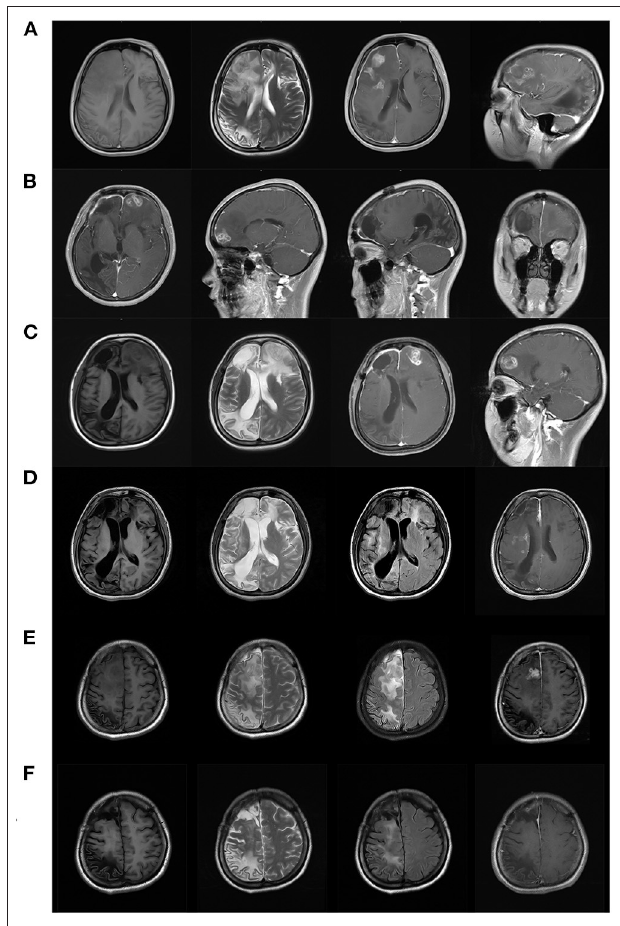
FIGURE 1 | Neuroimaging results of cerebral sparganosis in the case. (A) Six years after the onset (aged 22), tumor-like occupation foci at the right frontal lobe with edema and irregular enhancement causing midline shift on MRI before the first operation. Note that regular ring-shaped enhancement appeared on the sagittal view (the rightmost figure) (Left to right: T1, T2, axial T1 post gad, sagittal T1 post gad). (B) Three months after the operation, the enhanced foci shifted to the left frontal lobe, and postoperative encephalomalacia occurred at the original right frontal lobe on her follow-up MRI images (Left to right: axial T1 post gad, sagittal T1 post gad (left side), sagittal T1 post gad (right side), coronal T1 post gad). (C) Five months after the operation, a typical tunnel sign at the left frontal lobe was found on both axial and sagital view of her repeated MRI with enhancement (Left to right: T1, T2, axial T1 post gad, sagittal T1 post gad). (D) Three years after the operation (aged 25), the patient came to our center with left side paralysis. Restricted enhancement foci in the right centrum semiovale and basal ganglia with punched-out and tunnel-like presentation were found at the right basal ganglia (Left to right: axial T1, T2, T2 FLAIR, T1 post gad). (E) Four years after the operation (aged 26), the larva moved to the superficial area of the right frontal lobe where surgical removal became possible (Left to right: axial T1, T2, T2 FLAIR, T1 post gad). (F) 16 months after the removal operation (aged 28), MRI revealed softened foci, gliosis and shrinkage of the parenchyma at the right frontal and parietal lobe. No focal or meningeal enhancement was found (Left to right: axial T1, T2, T2 FLAIR, T1 post